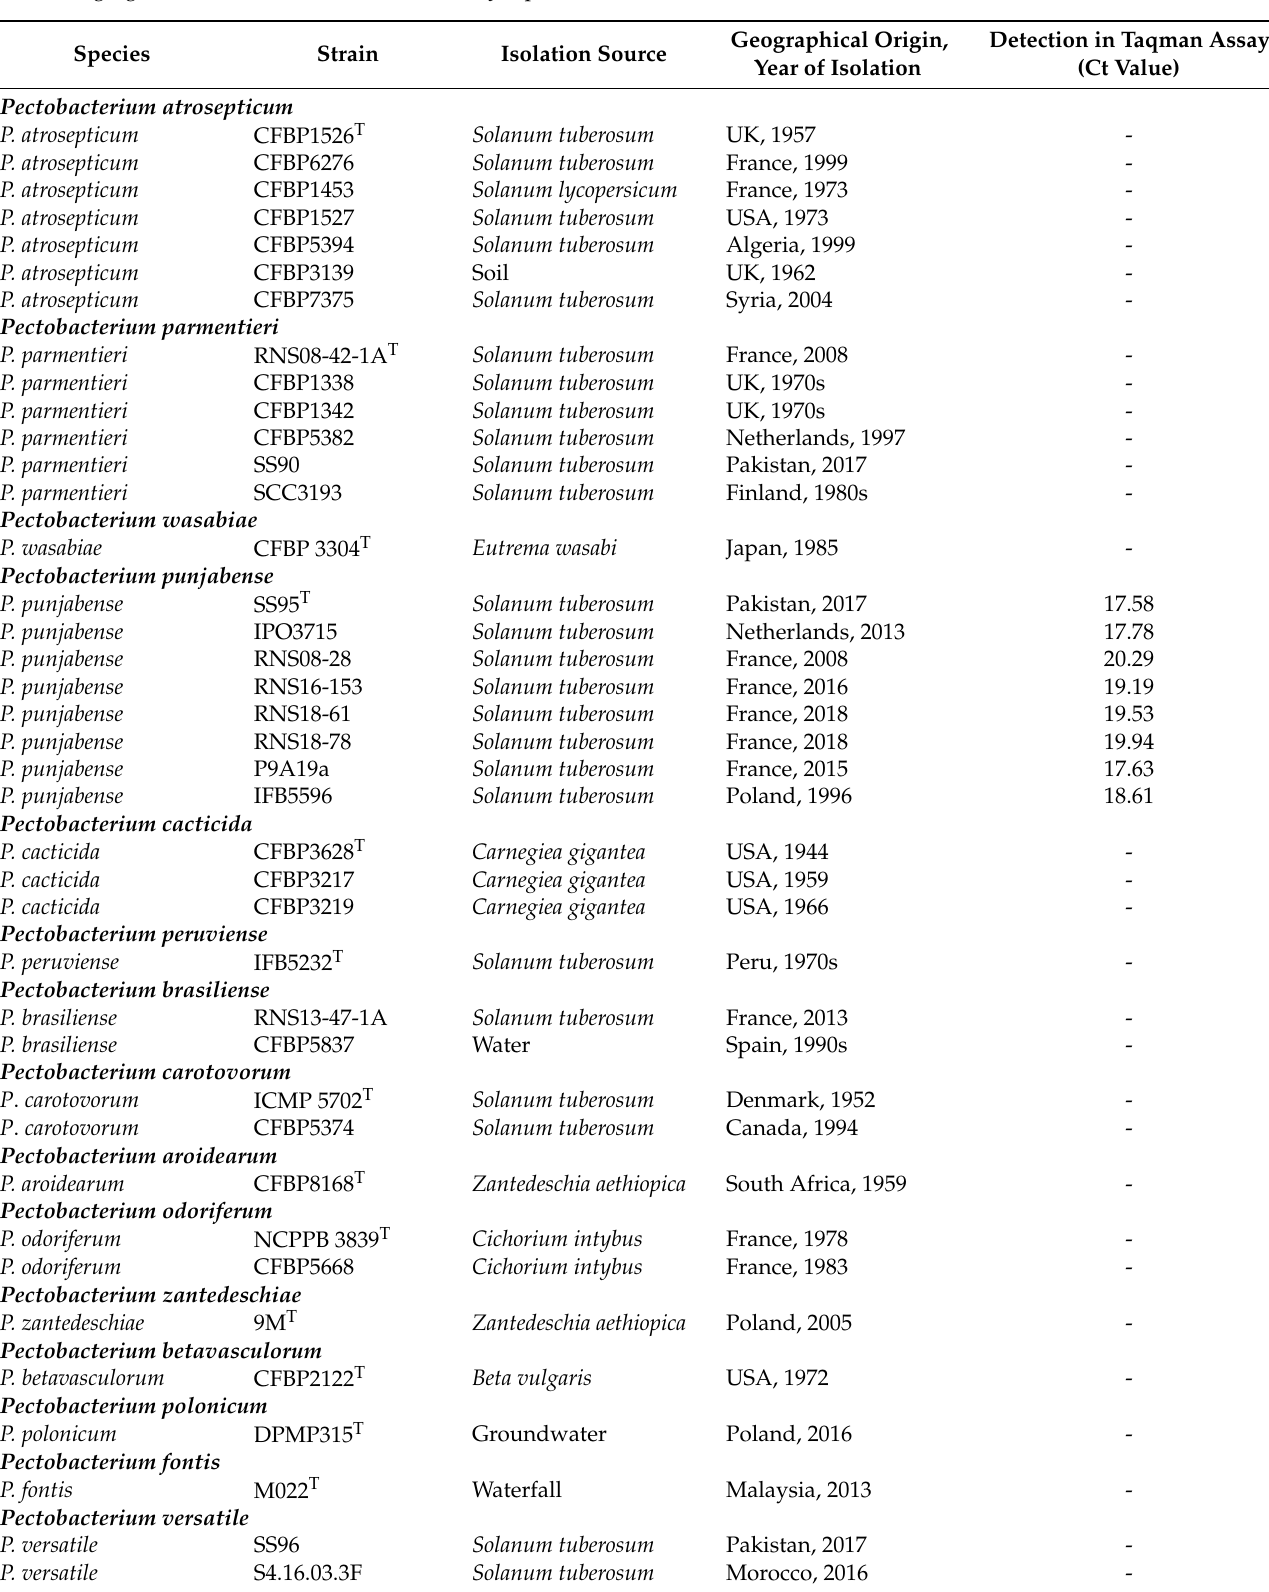
Table 4. Specificity of the qPCR Taqman 2b for detection of Pectobacterium punjabense on DNA extracted from strains belonging to various Pectobacterium and Dickeya